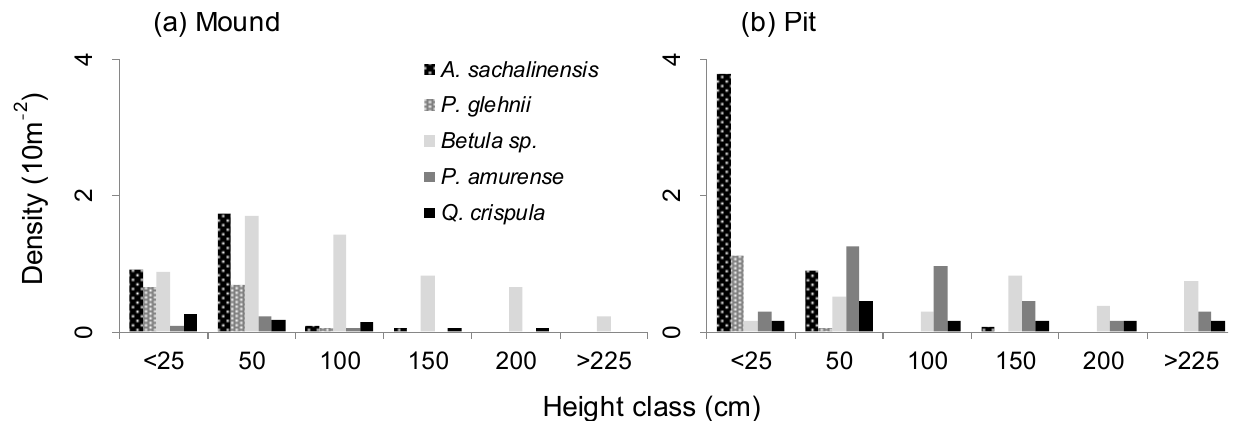
Figure 2. Height-class distribution of the major tree species grown on the microtopographies (( a ): mounds; ( b ): pits) at the 10th growing season.